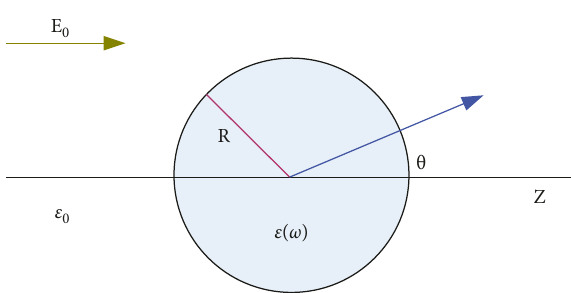
Figure 2: Schematic diagram of a uniform sphere in an electro- static